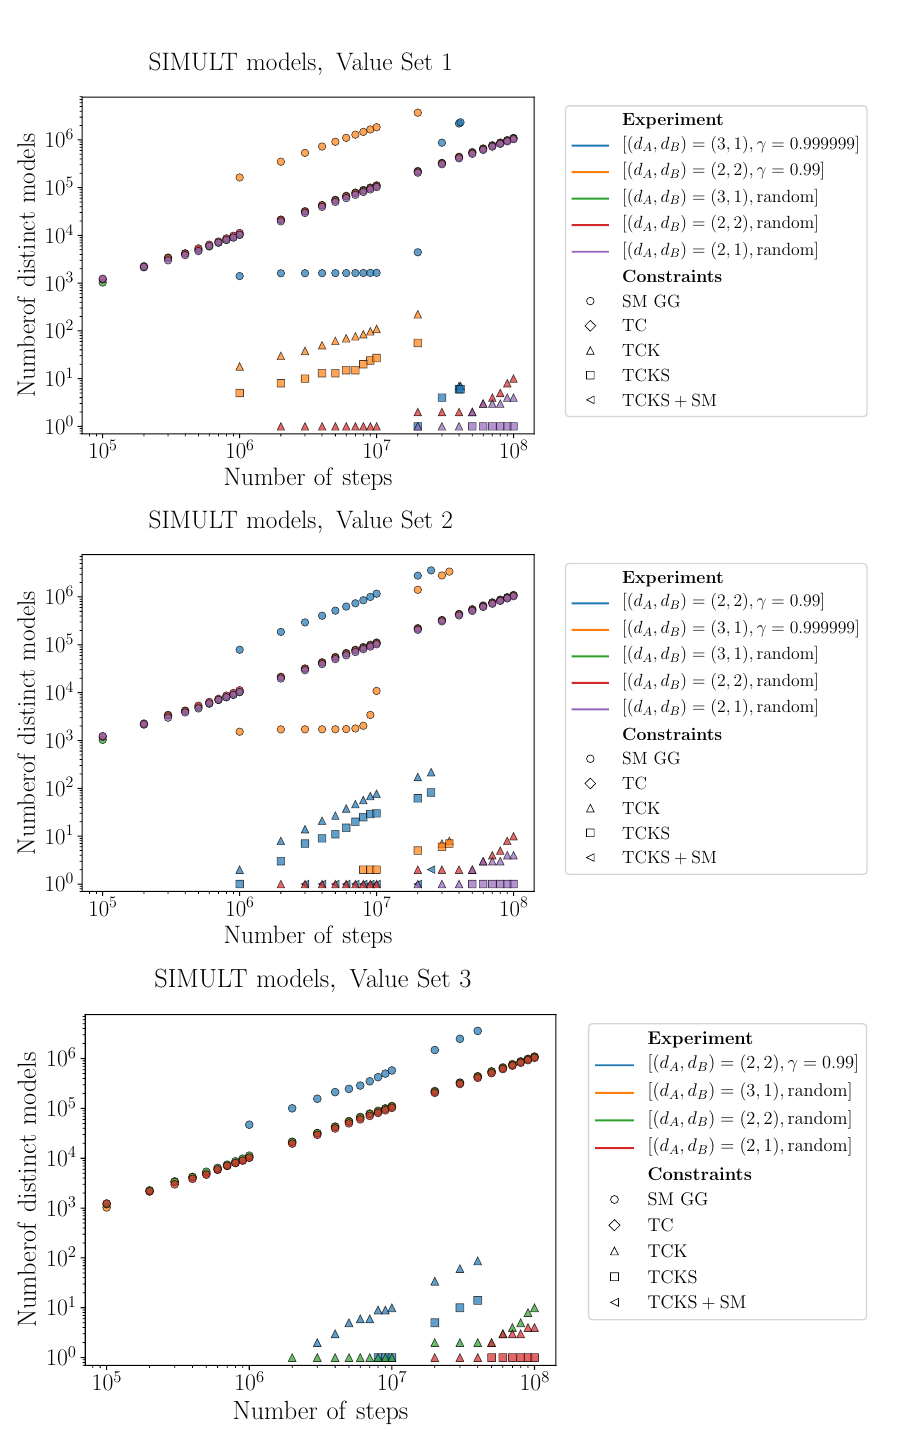
Figure 6 . Experimental results for reward function SIMULT. Results depend on choices of value sets as in table 2. Results for value sets 1, 2, and 3 are at top, middle, and bottom, respectively.